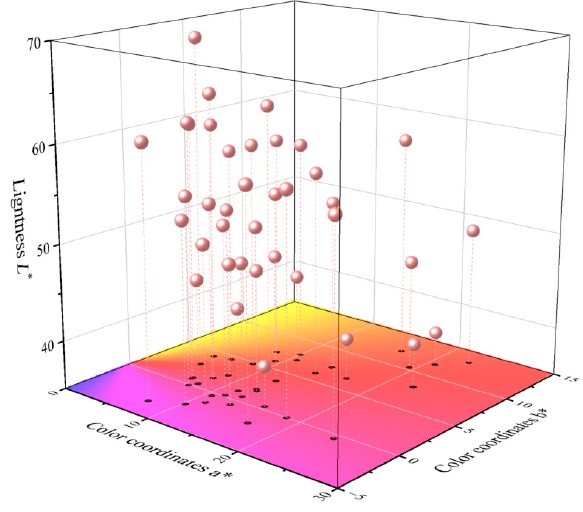
Figure 2. Cast point diagram of spinel color parameters L*, a*, b* under D65 light source. Table 1. Correlation analysis between spinel color parameters under D65 light source. ** At level 0.01 (double tail), the correlation was significant.